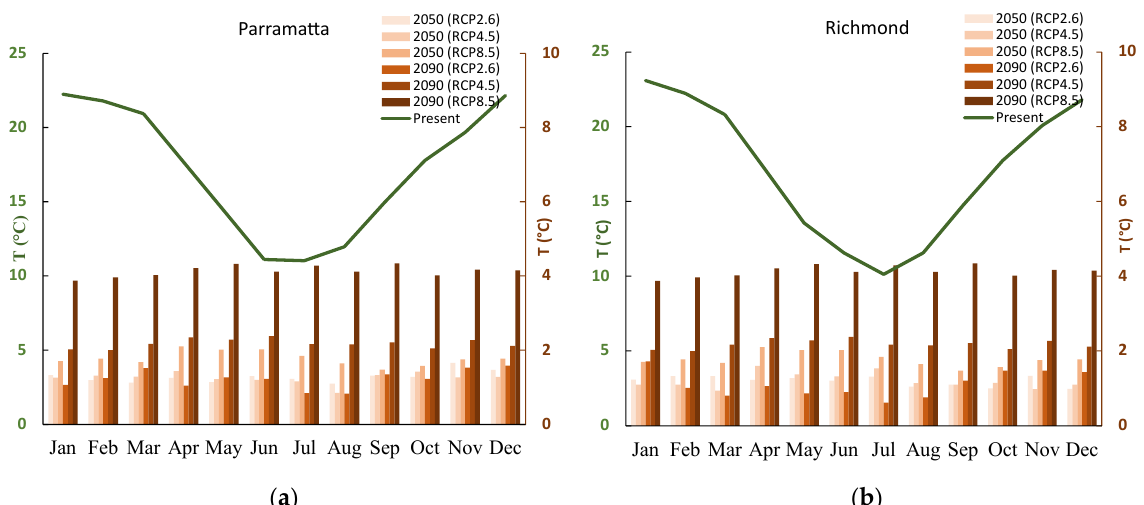
Figure 5. The impact of climate change on ( a ) Parramatta; ( b ) Richmond.